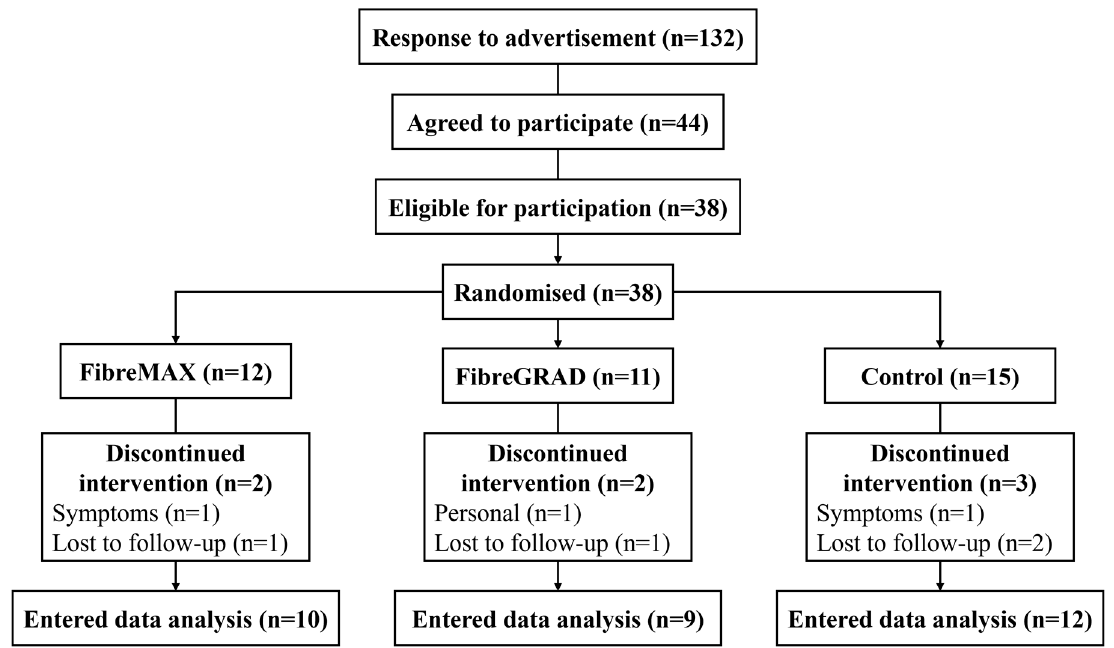
Figure 1. Consort diagram of study flow.